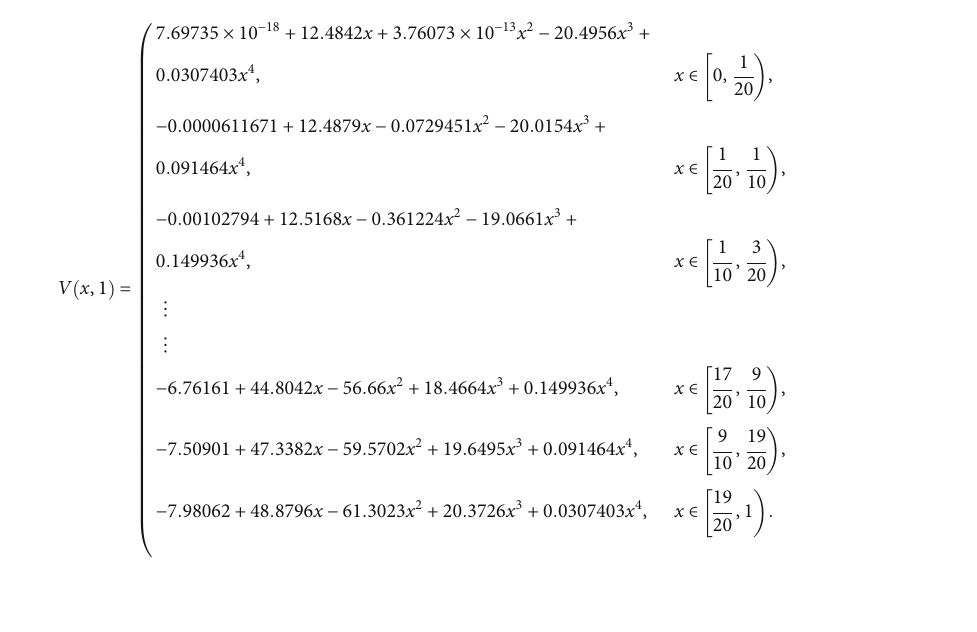
approximate solutions. 2D and 3D absolute errors are plot- ted in Figure 6. The numerical solution when h = 0 : 05 , t = 1 , and Δ t = 0 : 01 is given